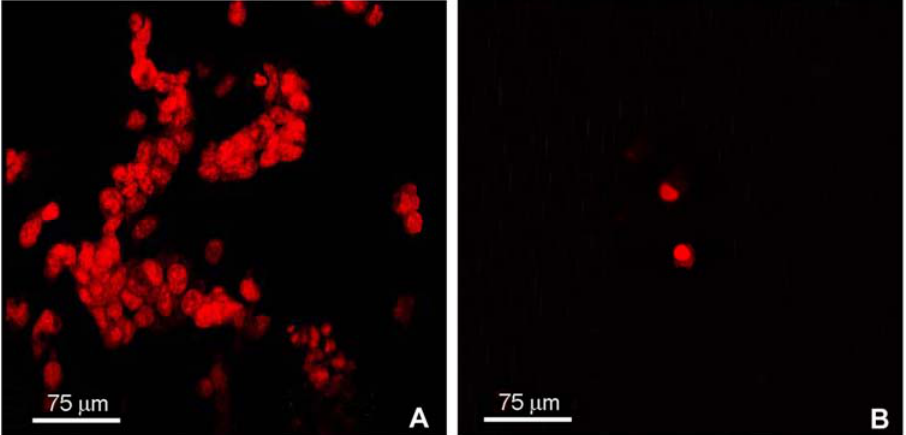
Figure 3. Confocal microscopy of J111 cells grown for 3 (A) and 5 (B) days on C2A25 membranes made of type I collagen from tendons and type II collagen from articular cartilage (see Experimental Section). Cells were labeled with propidium iodide prior to microscopy